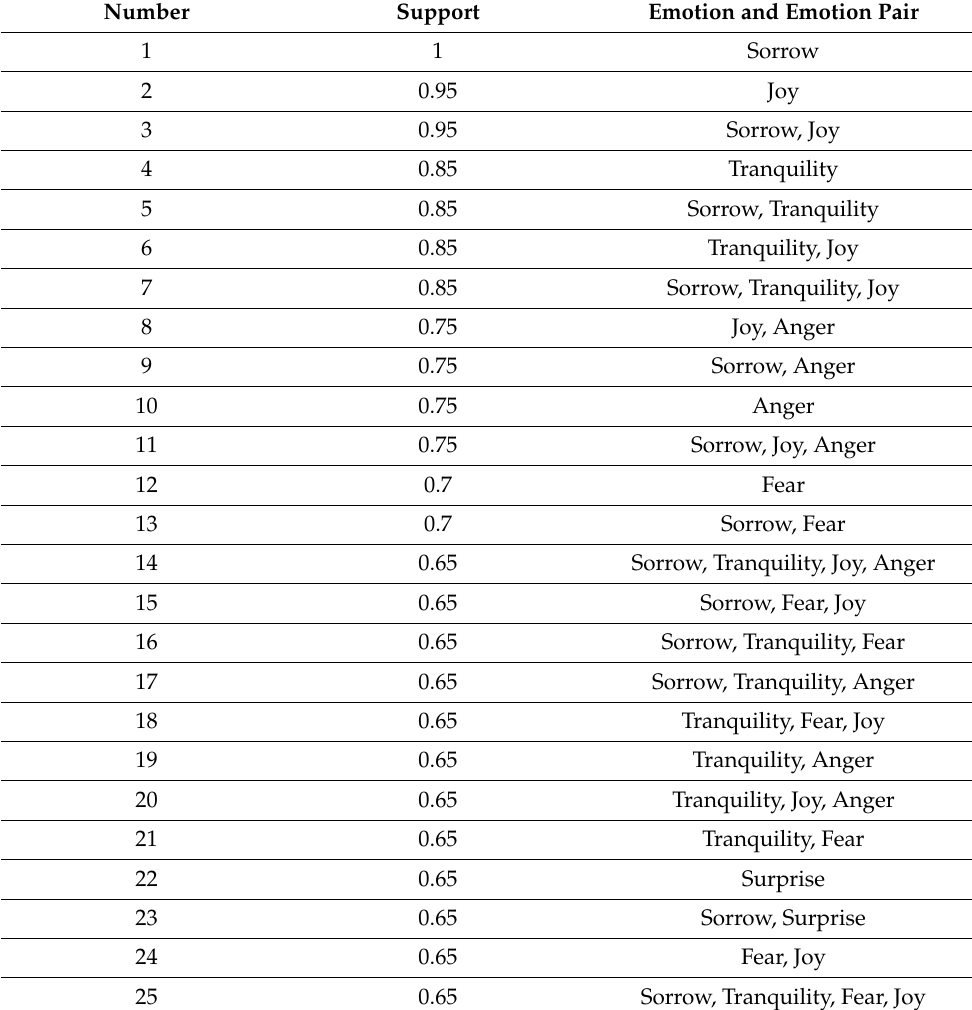
Table 5. Association rule support